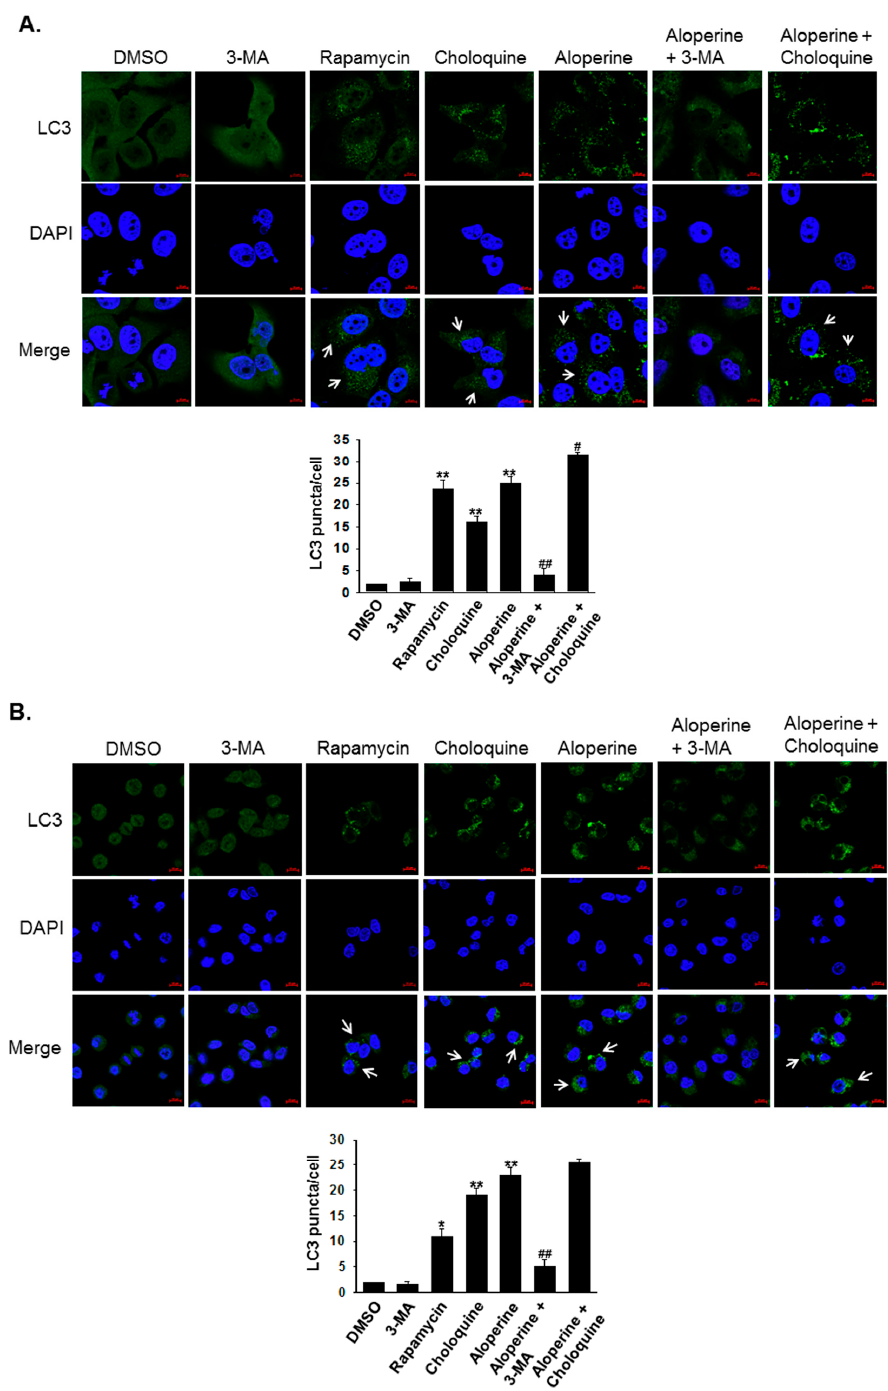
Figure 3. Autophagosome monitoring in human thyroid cancer cells following aloperine treatment. ( A ) KMH-2 and ( B ) IHH-4 cells were incubated with 3-MA (5 mM), rapamycin (30 µM), or aloperine (200 µM) for 24 h, and autophagosome formation was examined using immunofluorescence staining. LC3 ( green ) was used to label autophagosomes and DAPI to label the nucleus ( blue ). DMSO was used as a negative control; 3-MA was used as the autophagy inhibitor and rapamycin as the autophagy inducer. Cells with elevated autophagosome signaling are labeled with an arrow. Autophagosome puncta in the cells were identified and quantified in 30 cells. * p < 0.05, ** p < 0.01, compared with the DMSO group. ## p < 0.01, compared with the aloperine group. Three independent experiments were performed, and results of one of these are shown.